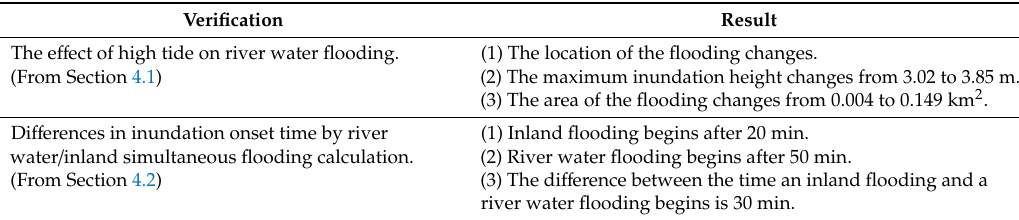
Table 3. Verification